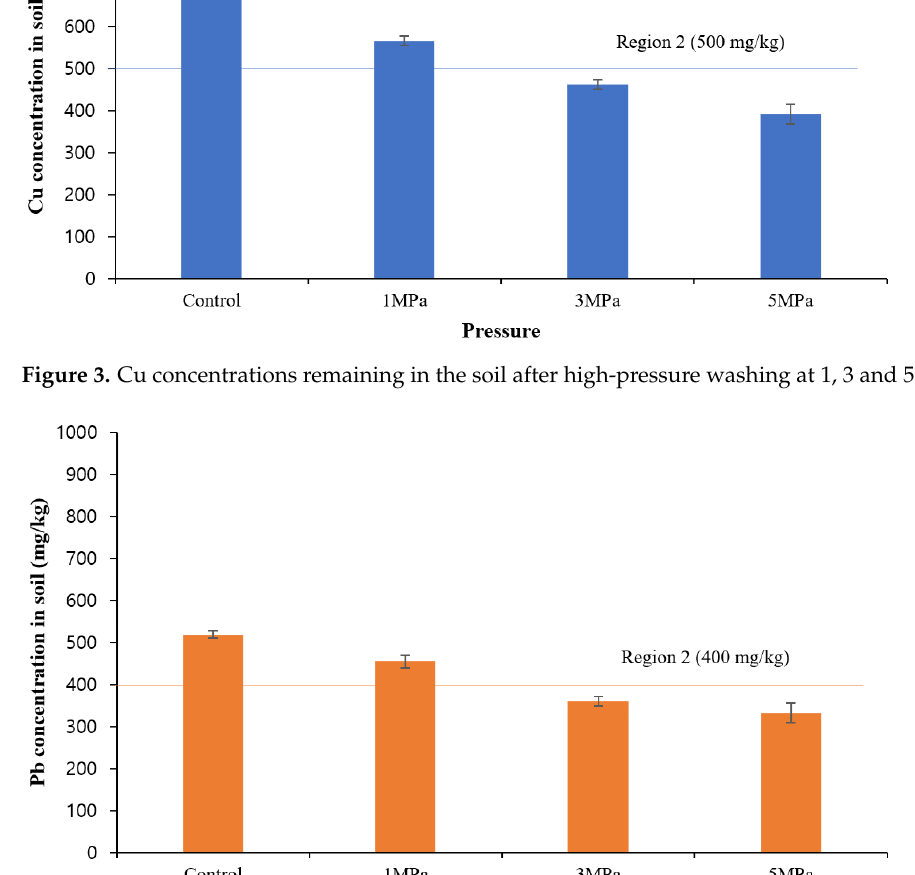
Figure 5. Zn concentrations remaining in the soil after high-pressure washing at 1, 3 and 5 MPa. 3.3. Optimal Solid-to-Liquid Ratio To determine the optimal input S/L ratio, the pressure was fixed at 5 MPa and S/L ratios of 1:1, 1:3, and 1:5 were applied, and the removal efficiencies were compared (Figures 6 – 8). The highest removal efficiency, recorded at a S/L ratio of 1:1, corresponded to 37.7%, 36.6% and 45.1% in Cu, Pb, and Zn, respectively. The removal efficiency in- creased as the S/L input ratio increased. In soil washing, contact between the cleaning agent and soil particles declines as the S/L ratio increases, thus reducing the removal ef- ficiency. It has been reported that suitable S/L ratios range from 1:5 to 10 [13]. However, Feng et al. [26] reported that in attrition washing for diesel-contaminated soil, when the solid concentration was increased from 70% to 80%, effective scrubbing was achieved due to particle friction, and the residual diesel concentration sharply decreased. Even in a high-pressure attrition washing process, applying a low S/L ratio may reduce the op- portunities for particles to contact and hence decrease the removal efficiency. Since the amount of treated wastewater increases at lower S/L ratios, a suitable S/L ratio must also be considered from an economic perspective [13]. When a S/L ratio of 1:0.5 was applied,